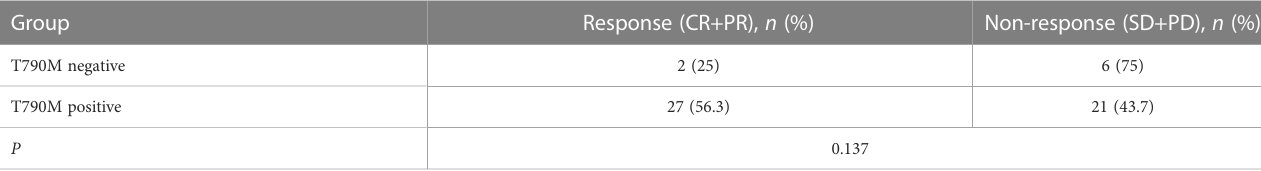
TABLE 5 Association between the status of EGFR T790M and the curative effect of the third generation of EGFR tyrosine kinase inhibitors.